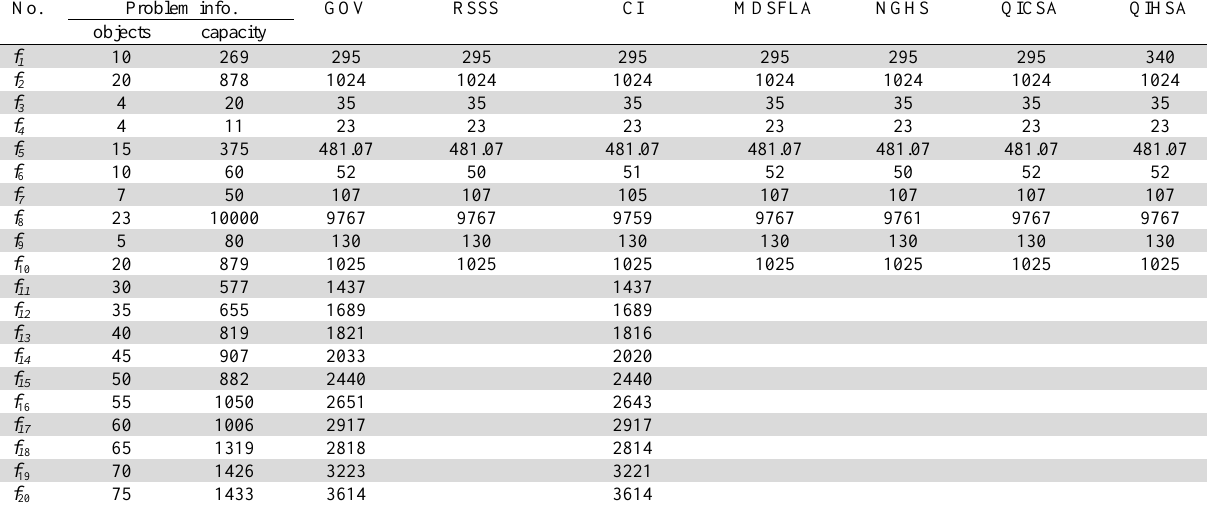
Results Comparison from CI, MDSFLA, NGHS, QICSA, QIHSA and RSSS